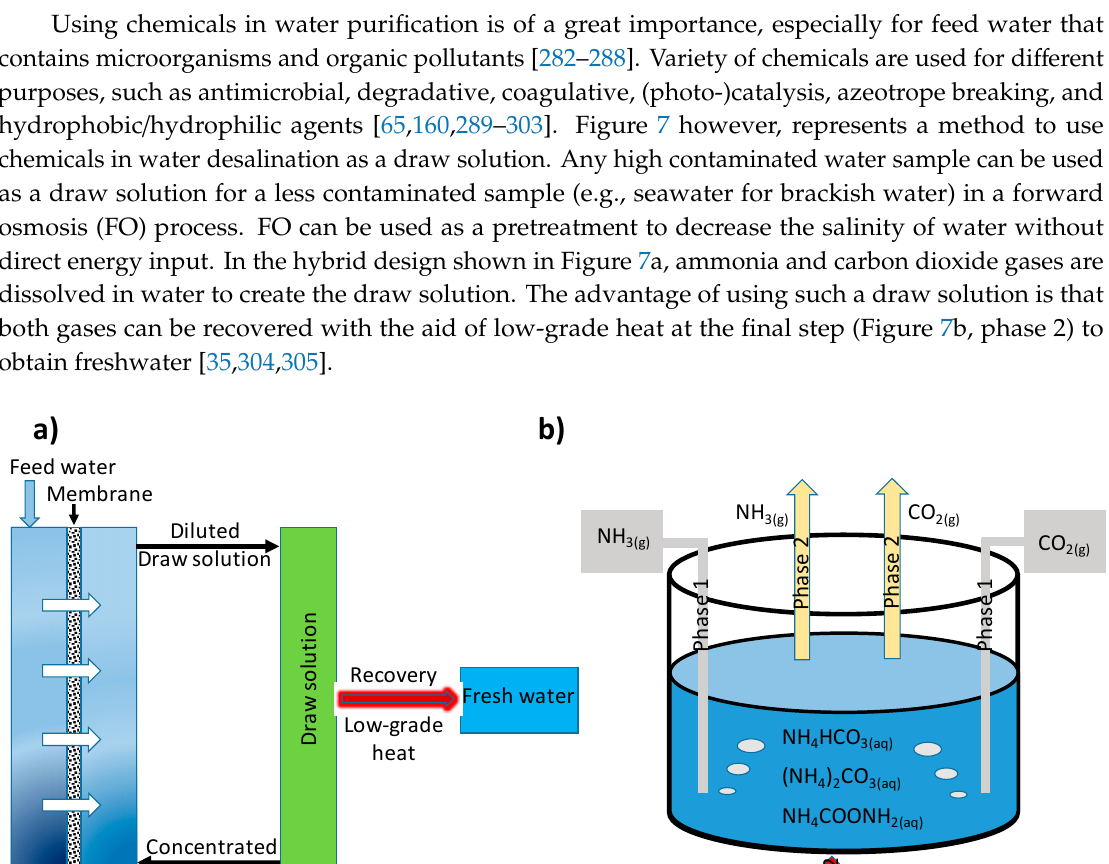
Figure 6. A thermal-based desalination strategy designed by EFD corporation .